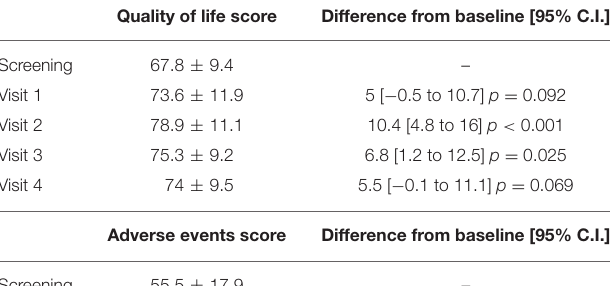
TABLE 5 | Longitudinal variations of primary and secondary end points. Quality of life score Difference from baseline [95%